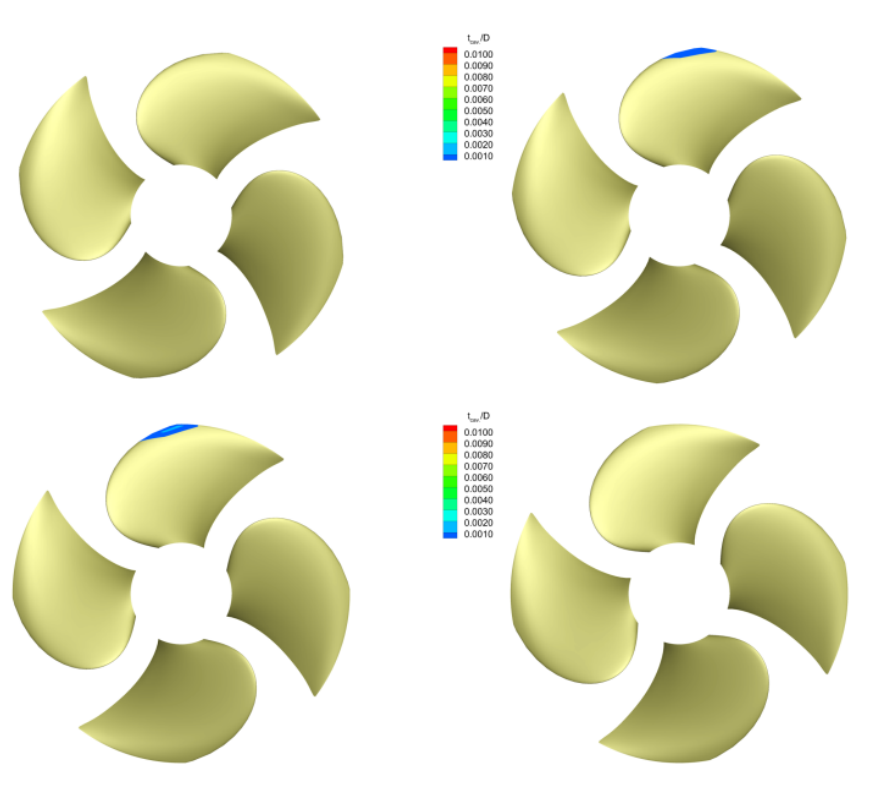
Figure 9: Predicted cavity extension (BEM) with Nominal inflow